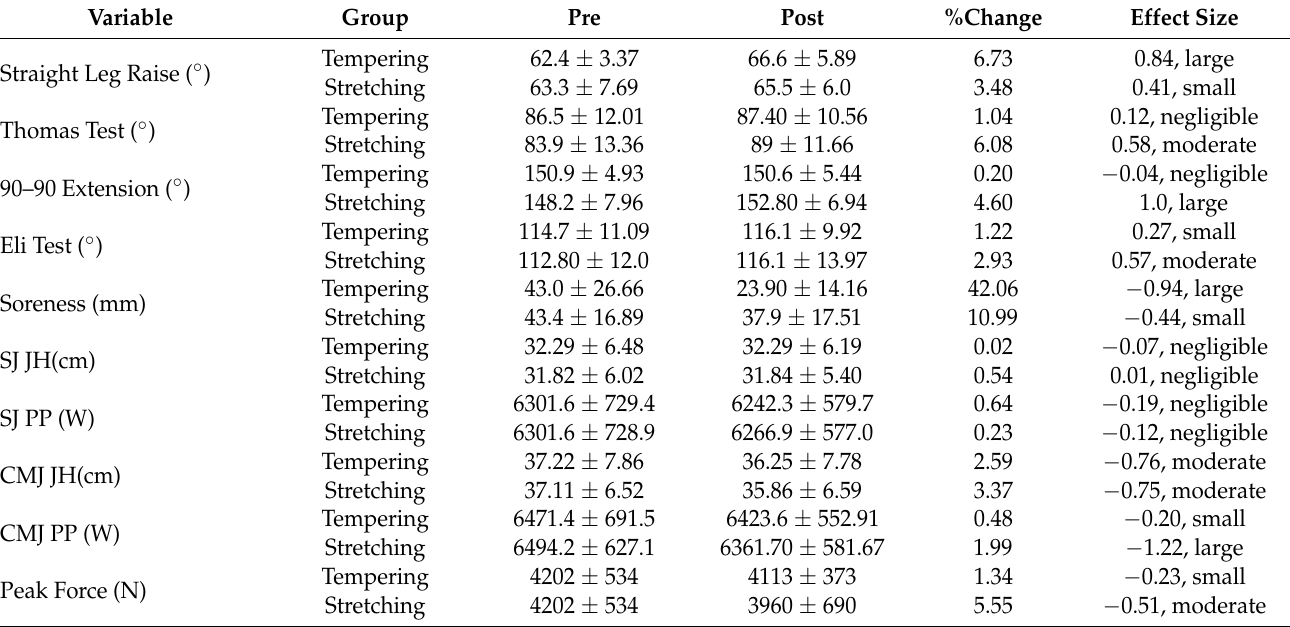
Table 2. Group averages presented as mean (M) ± standard